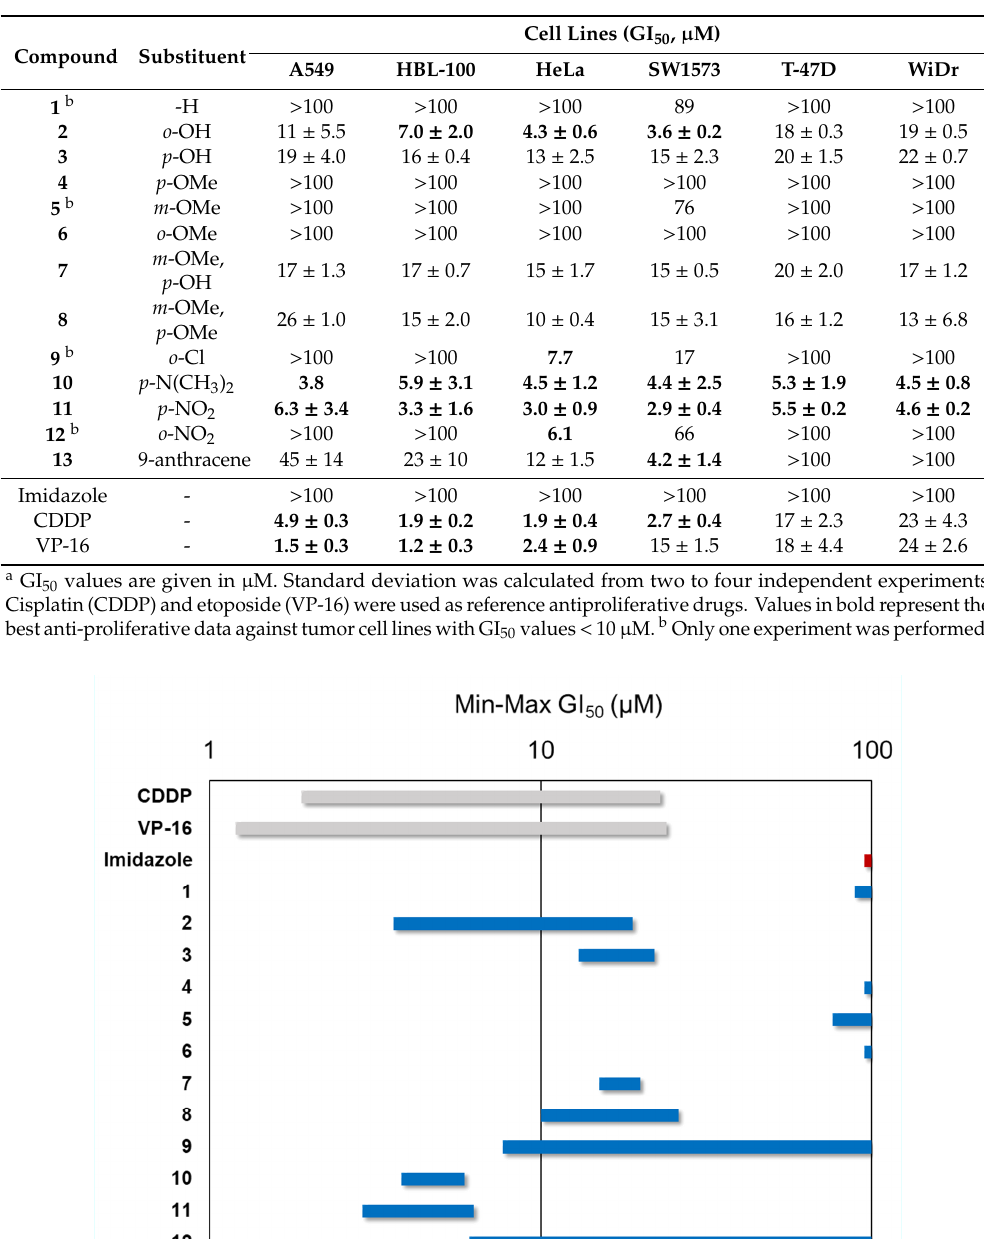
Table 2. Antiproliferative activity of compounds 1 – 13 against six human solid tumor cell lines a .